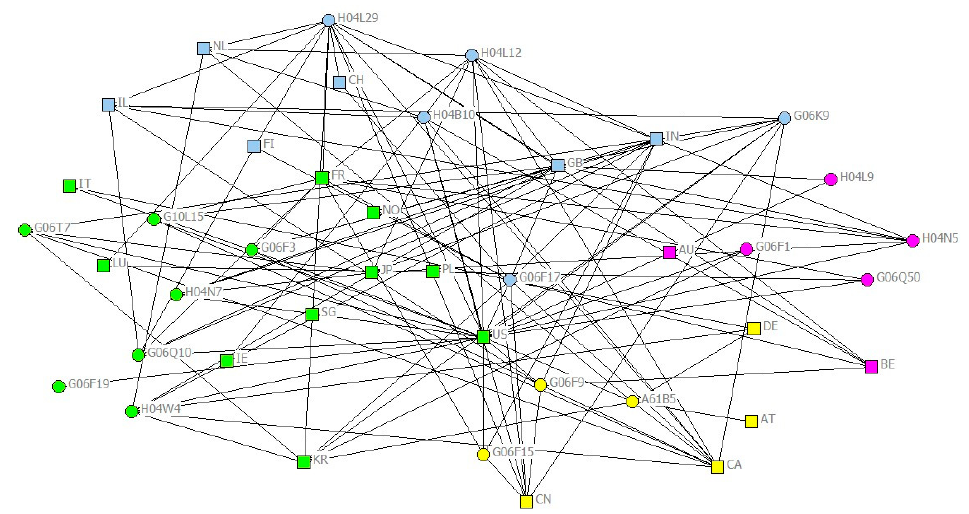
Figure 3. Two-mode network diagram based on faction analysis. Note: To simplify the figure, only technology nodes that appear in Tables 1 and 5, and Figure 2 are used.